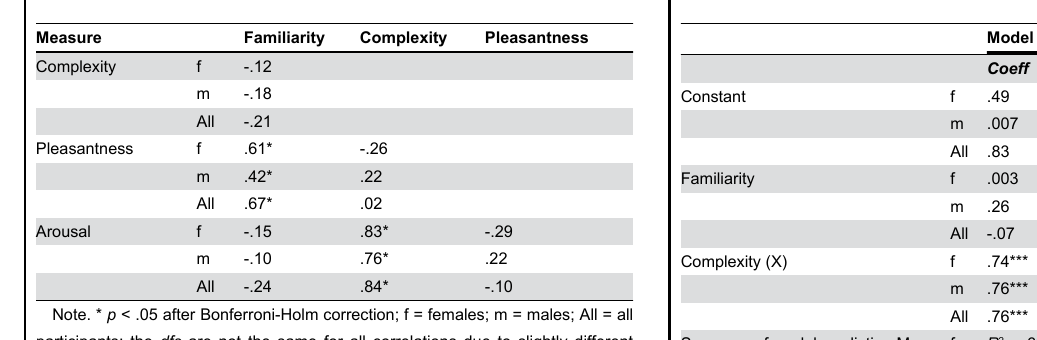
Table 14. Indirect effect of complexity (X) on pleasantness (Y) through arousal (M) with familiarity as a covariate, calculated for excerpts of piano solo music and piano trios All (N = 76, n = 73, n = All males females